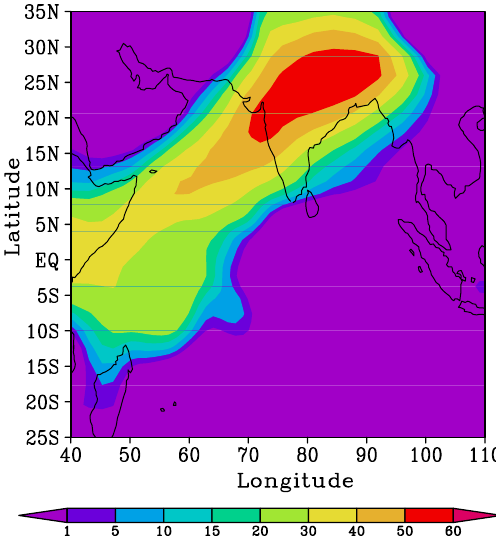
Fig. 16. Contribution (%) of the Indian sources to sulphate burden over the INDOEX region during the